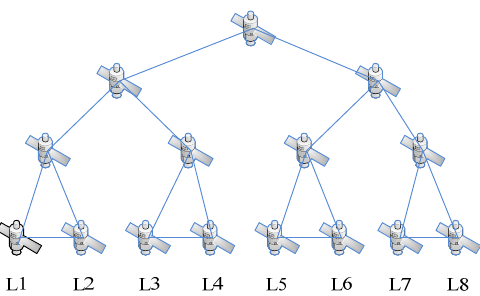
Figure 2. Satellite network ( L 1– L 8 represents the lowest altitude satellite node) (time T1).